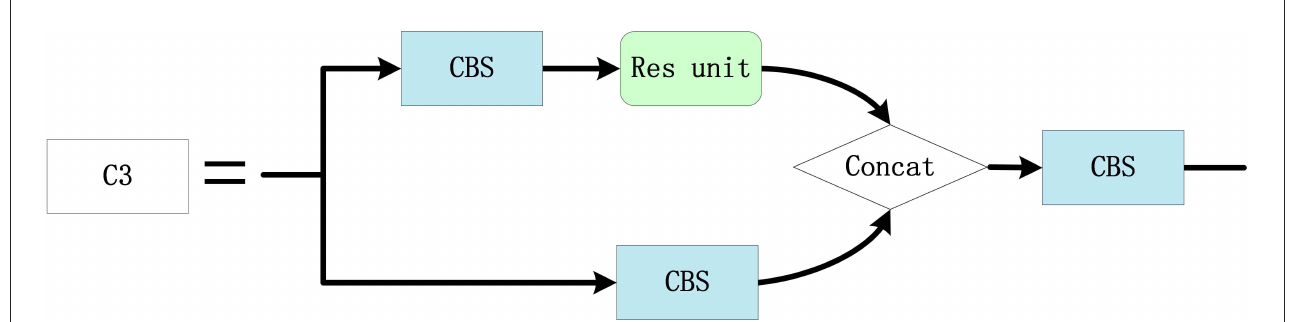
FIGURE8 C3 module configuration.